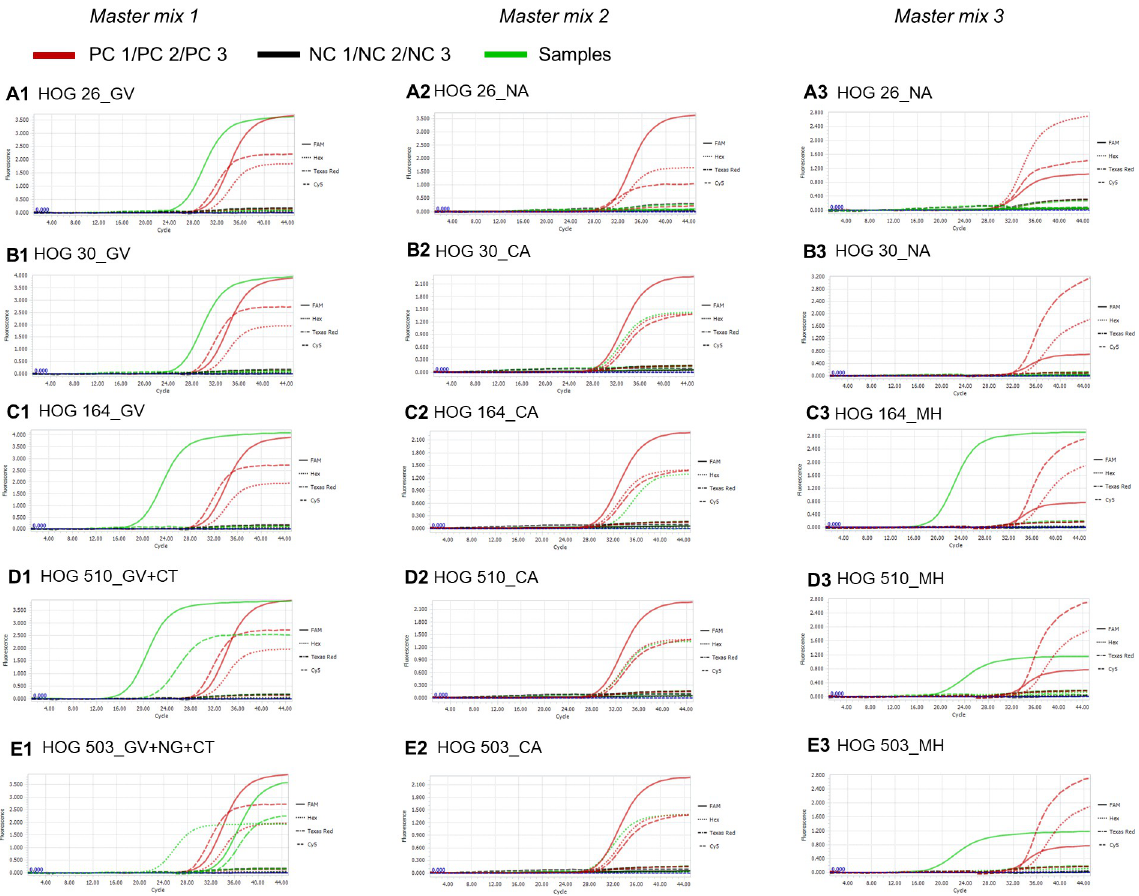
Fig 3. Real-time PCR amplification curves taken from five representative vaginal swab clinical samples. Samples include positive with one (A1–A3), two (B1–B3), three (C1–C3), four (D1–D3), and five (E1–E3) pathogens among the screened nine STIs. Positive and negative controls in the three master mixes 1/2/3 were PC 1/2/3 and NC1/2/3, respectively. Amplification curves for positive controls, negative controls, and positive clinical samples are presented in red, black, and green, respectively.